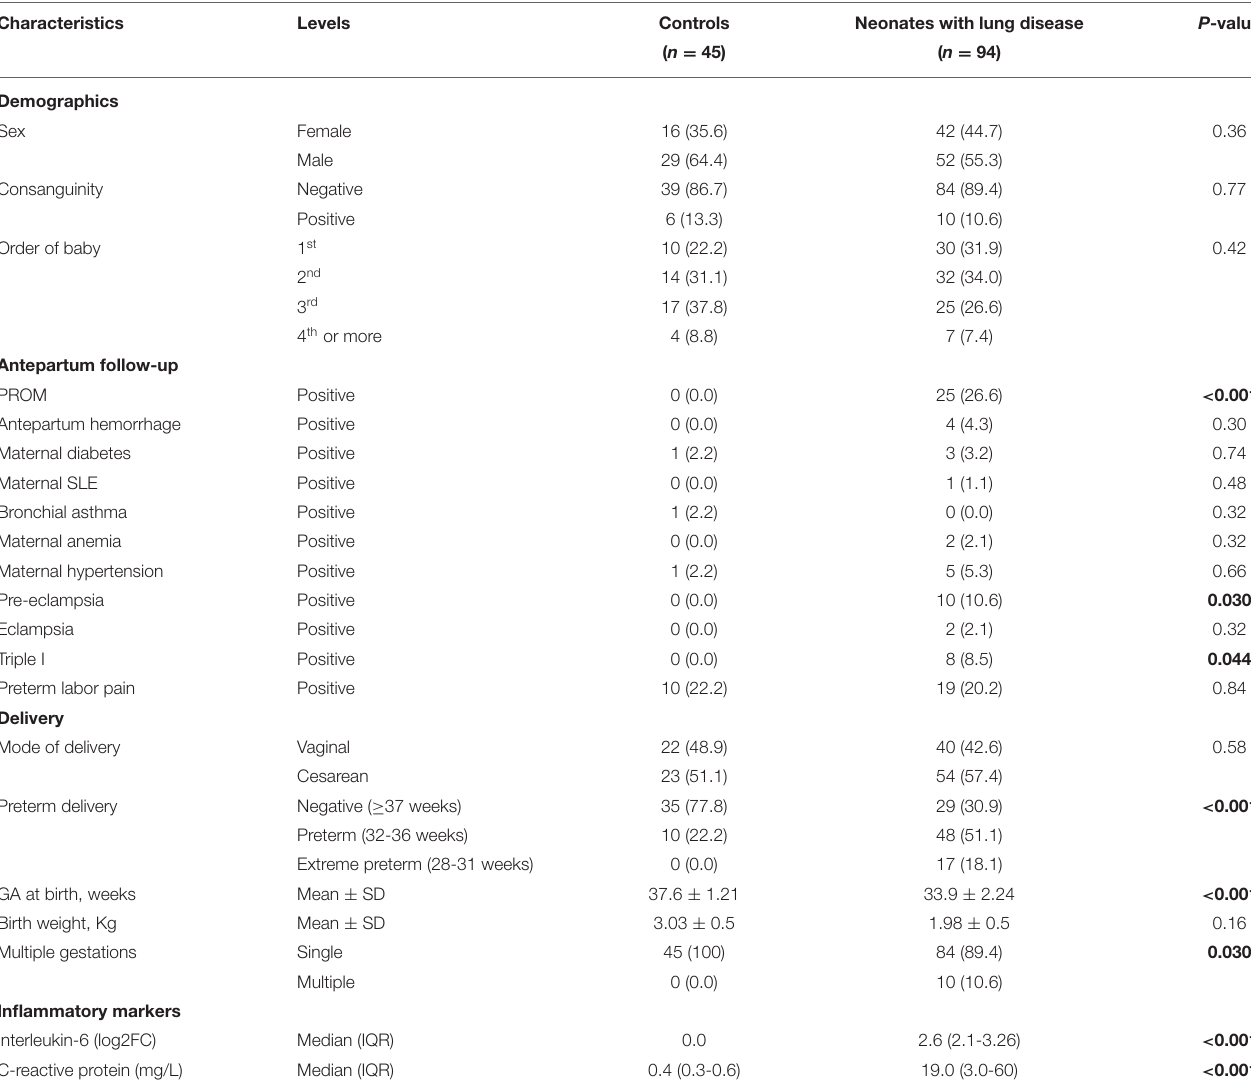
TABLE 1 | Characteristics of the study